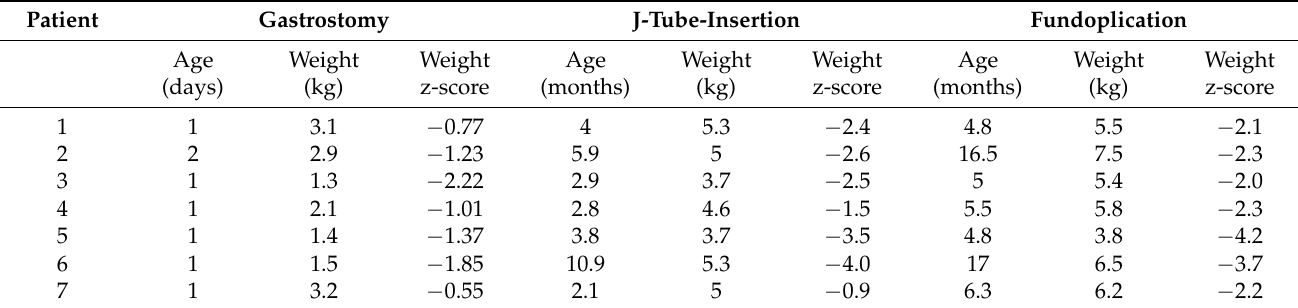
Table 3. Clinical parameters of the patients at different surgical